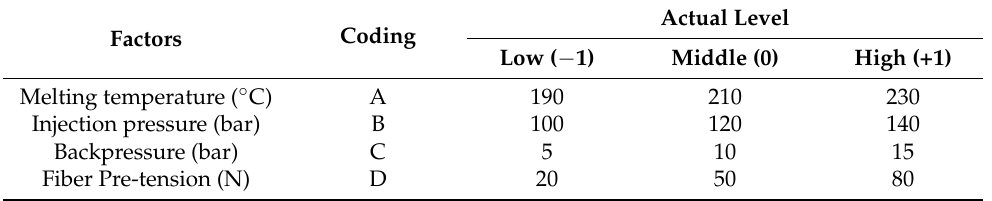
Table 3. Processing factors and